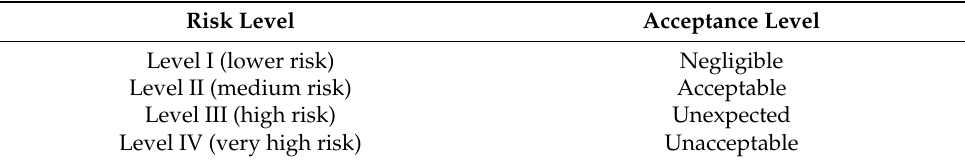
Table 5. Risk acceptance criteria.